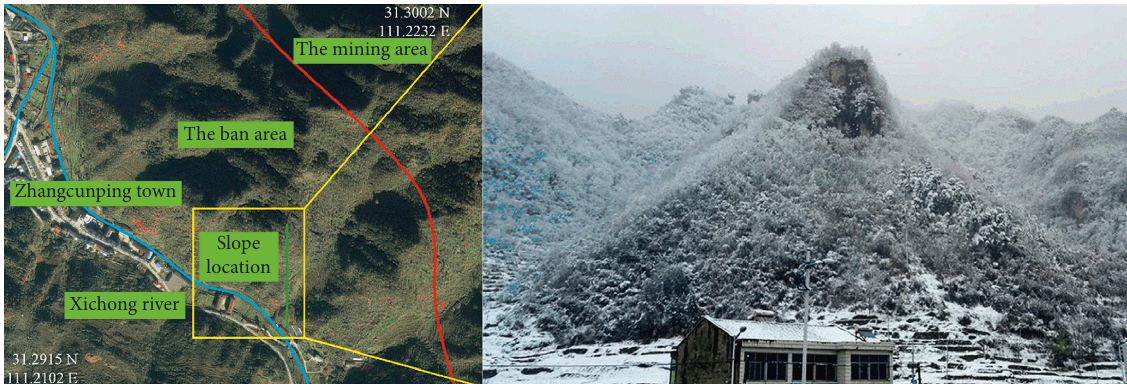
Figure 2: Positions and view of the